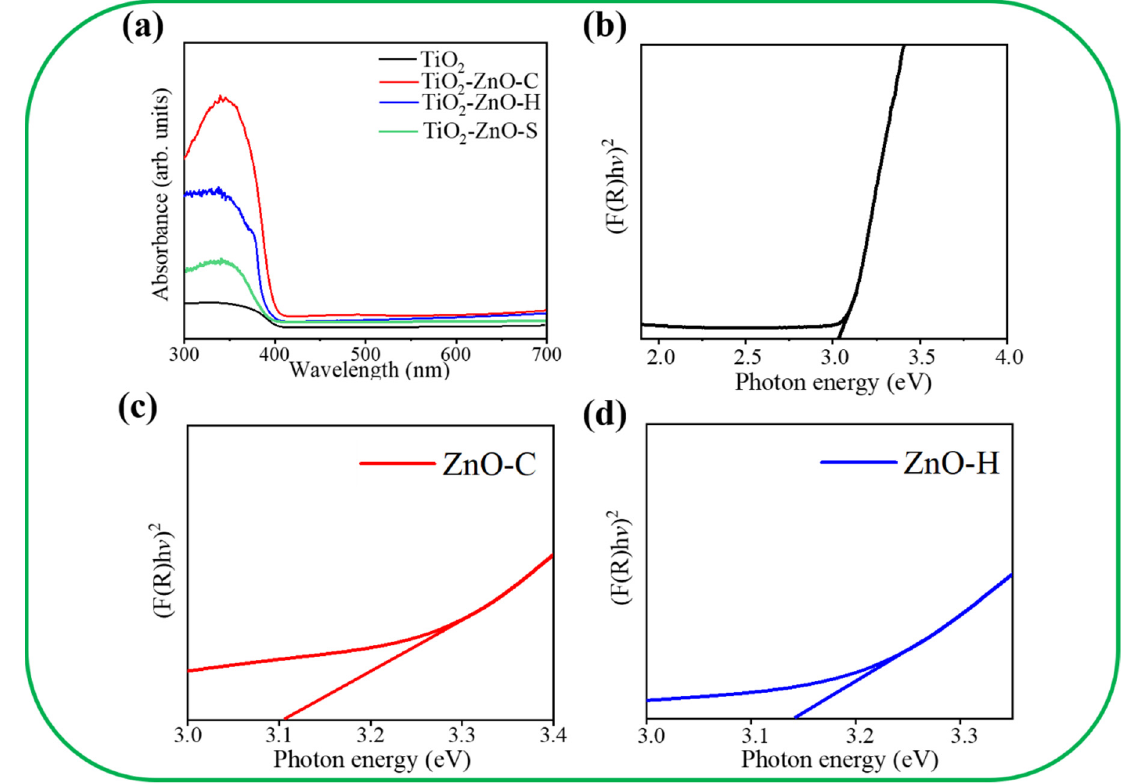
Figure 6. ( a ) Optical absorbance spectra of various samples. ( b ) Band gap of the TiO 2 . ( c ) Band gap of the ZnO nanodisks. ( d ) Band gap of the ZnO nanosheets.